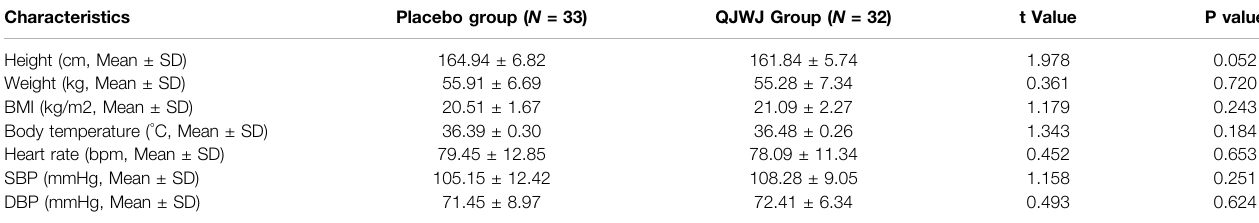
TABLE 1 | Characteristics of the participants at baseline. Characteristics Placebo group ( N = 33)